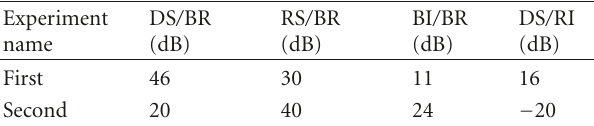
Table 2: Values of Deterministic Signal-to-background noise (SI / BN), random NB interference to BN (RI / BN), deterministic broadband interference to BN (BI / BN), and DS to random NB interference (SI / RI) for experiments First and Second.